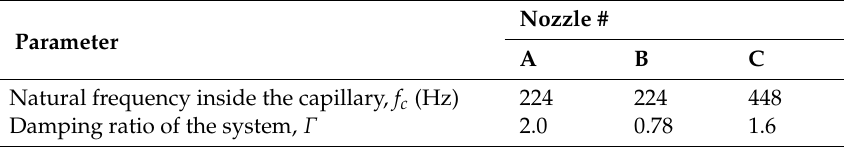
Nozzle # Nozzle # A B C A B C